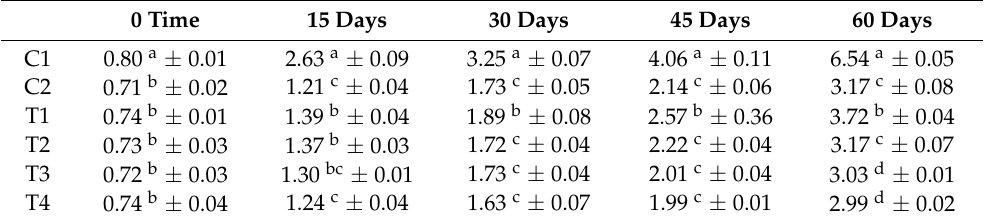
Table 7. Changes in the acid value (mg KOH g 1 ) of mayonnaise samples enriched with RCFE during storage.